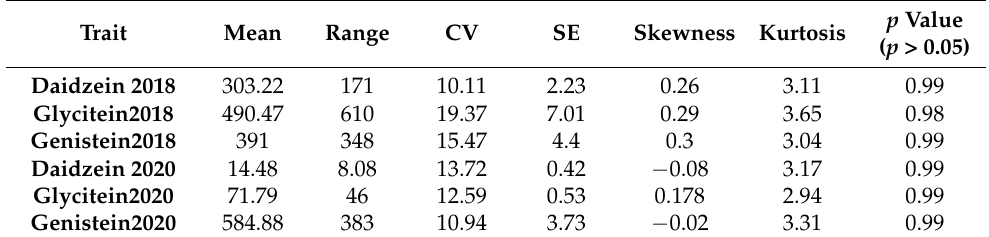
Table 2. Seed isoflavone means, ranges, CVs, skewness, and kurtosis in the FxW82 RIL population evaluated in Spring Lake, NC (2018) and Carbondale, IL (2020). Mean and range values are expressed in µ g/g of seed weight.